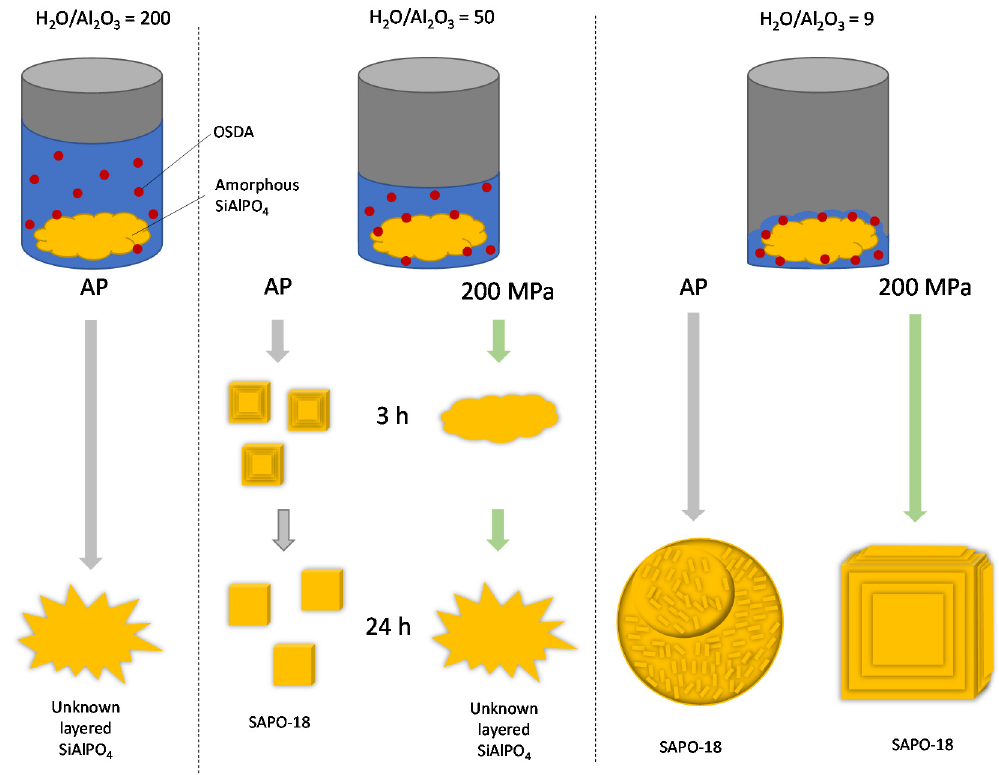
Figure 9. Schematic summary of the most relevant results obtained in the SAPO-18 crystallization under autogenous pressure (AP) and 200 MPa.